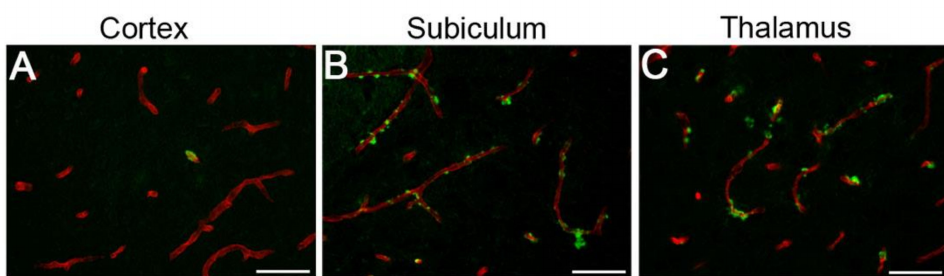
Figure 1. Cerebral microvascular amyloid accumulation in Tg-SwDI mice. Representative brain sections from 9-month-old Tg-SwDI mice stained with thioflavin S to identify fibrillar microvascular amyloid (green) and immunolabeled with an antibody to collagen IV to identify cerebral blood vessels (red). Microvascular amyloid deposits are observed in the cortex ( A ), subiculum ( B ), and thalamus ( C ). Scale bars = 50 µ m.